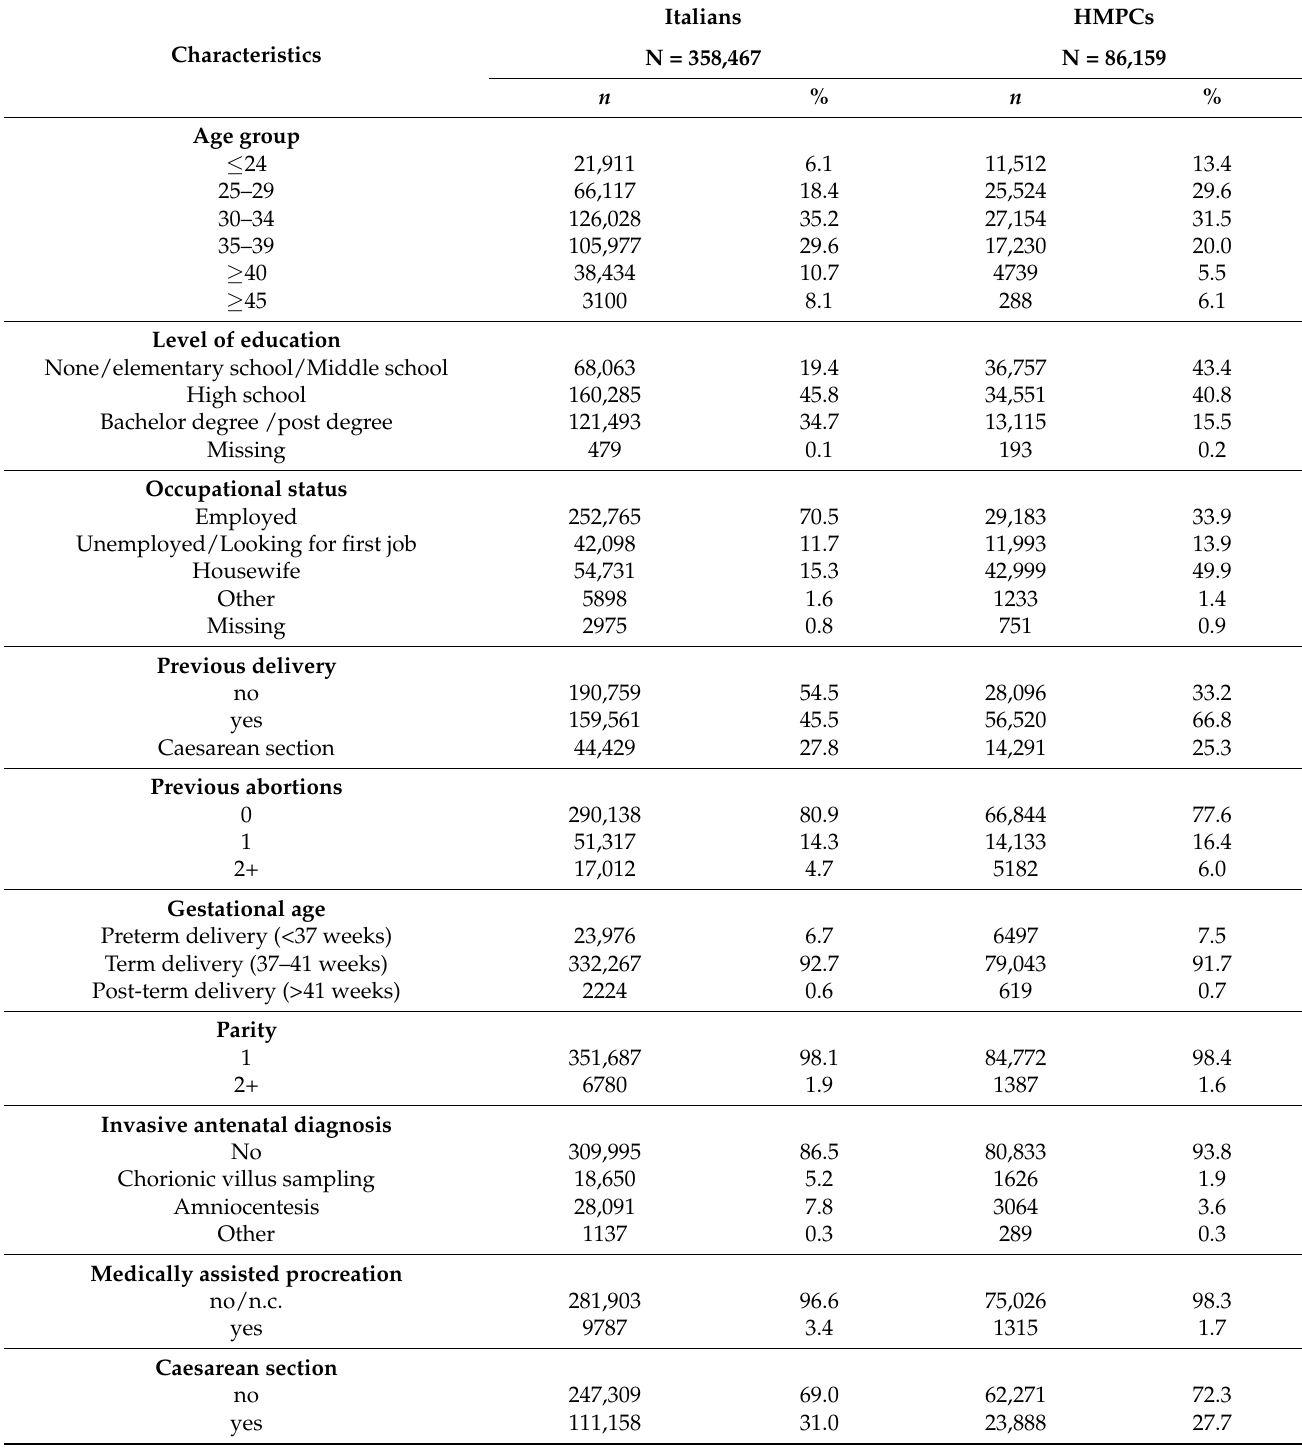
Table 1. Socio-demographic characteristics and obstetric history of Italian and HMPC